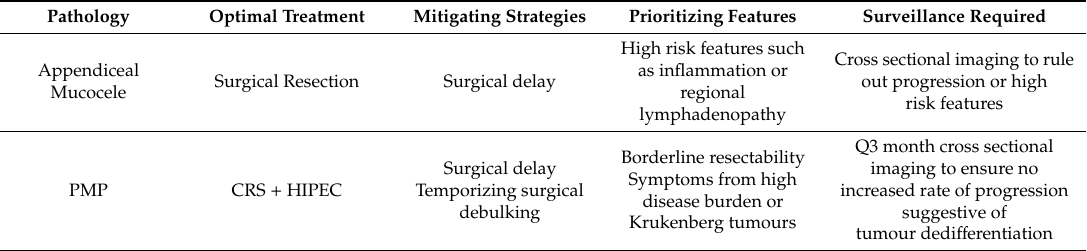
Table 1. Summary of treatment approaches, mitigating strategies, and surveillance for peritoneal disease in pandemic